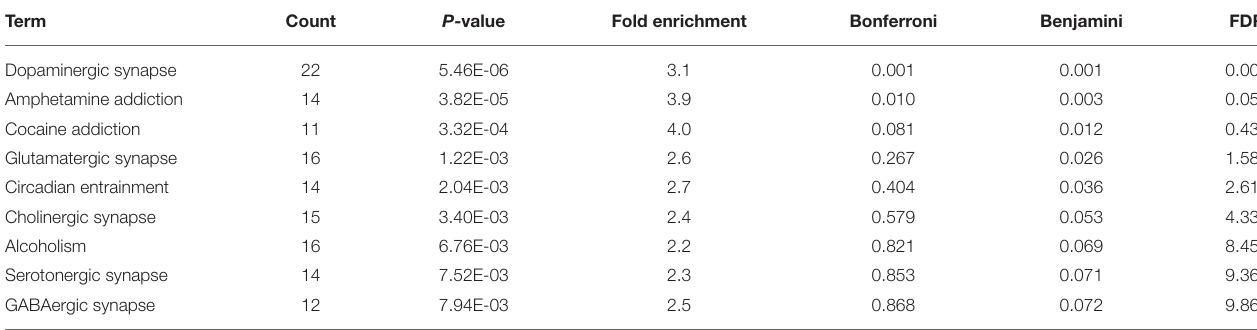
TABLE 3 | Functional annotation of the predicted target genes for eight DE microRNAs listed in Table 2 .